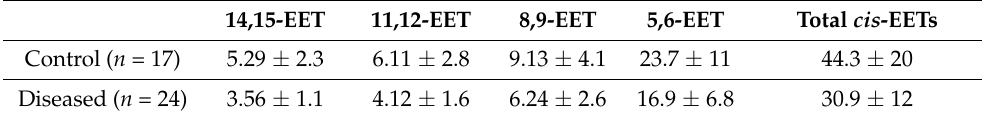
Table 1. Amount of cis -EETs (ng/mg of protein) in control and diseased human heart tissues.